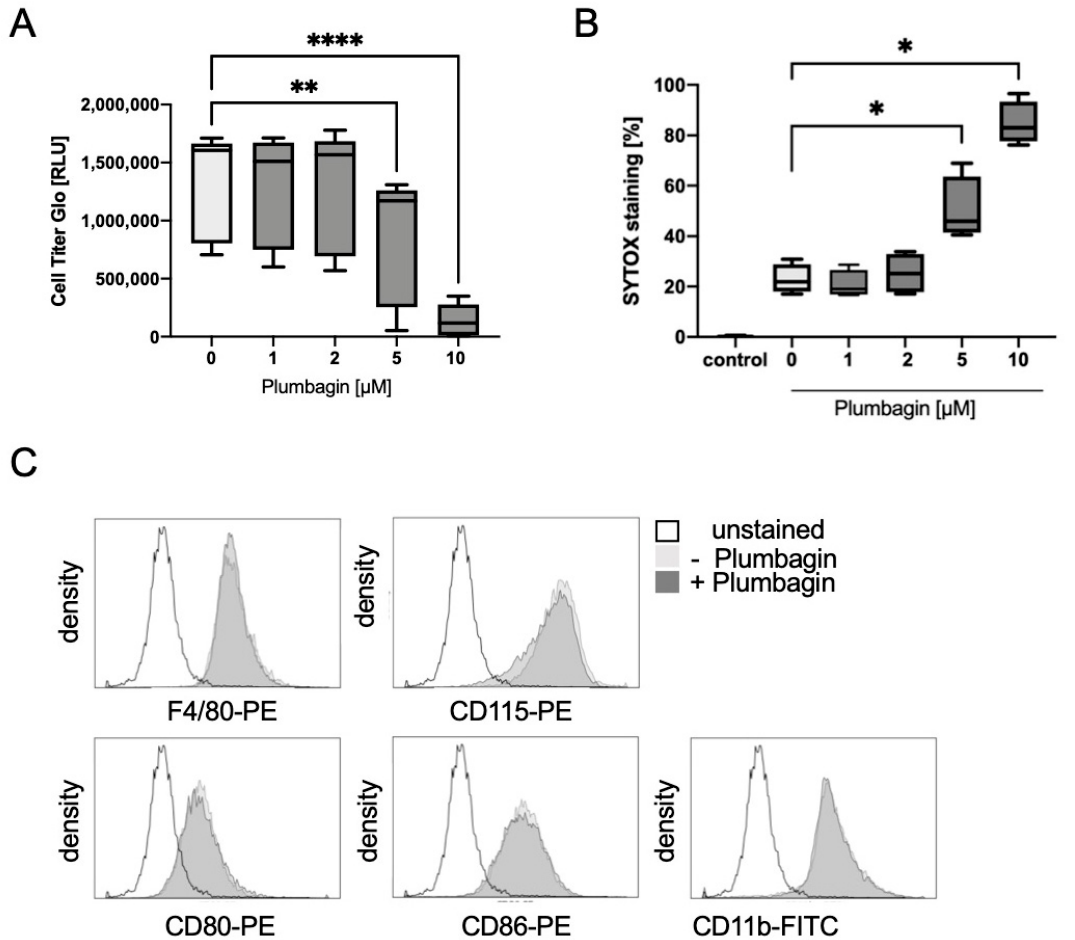
Figure 1. Plumbagin does not change the phenotype of bone marrow-derived macrophages: ( A ) the influence of increasing concentrations of plumbagin in the presence of 25 ng/mL M-CSF was tested after 48 h by measuring cell viability ( n = 3, with triplicates); ( B ) cell death triggered by increasing plumbagin concentrations was measured after the incubation of the cells with SYTOX after 48 h of treatment in the presence of M-CSF ( n = 4); statistical analysis was performed comparing the results to the positive control (M-CSF) in (A) using Friedman, and in (B) using Mann–Whitney test; ( C ) the effect of 2 µM plumbagin was tested on the expression of the macrophage marker molecules F4/80, CD11b, CD80, CD86 and CD115, respectively. The graphs represent one typical example ( n = 3). *: p ≤ 0.05; **: p ≤ 0.01; ****: p ≤ 0.0001.